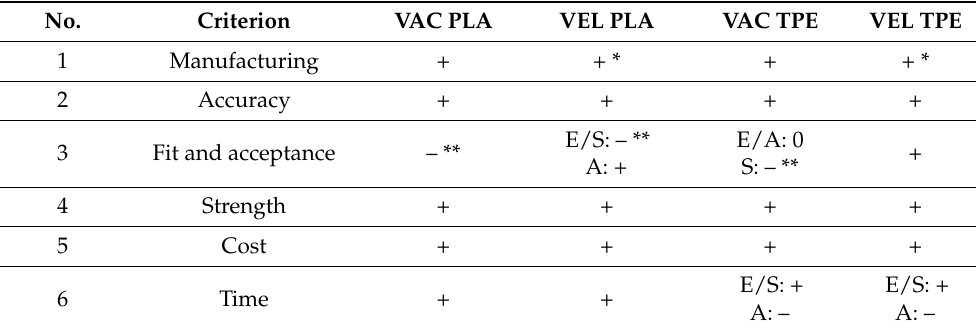
Table 5. Final assessment of the produced prosthetic sockets. Strategies: E—econo, A—accura, and S—strong; if no strategy indicated, assessment applies to all of them. No. VAC